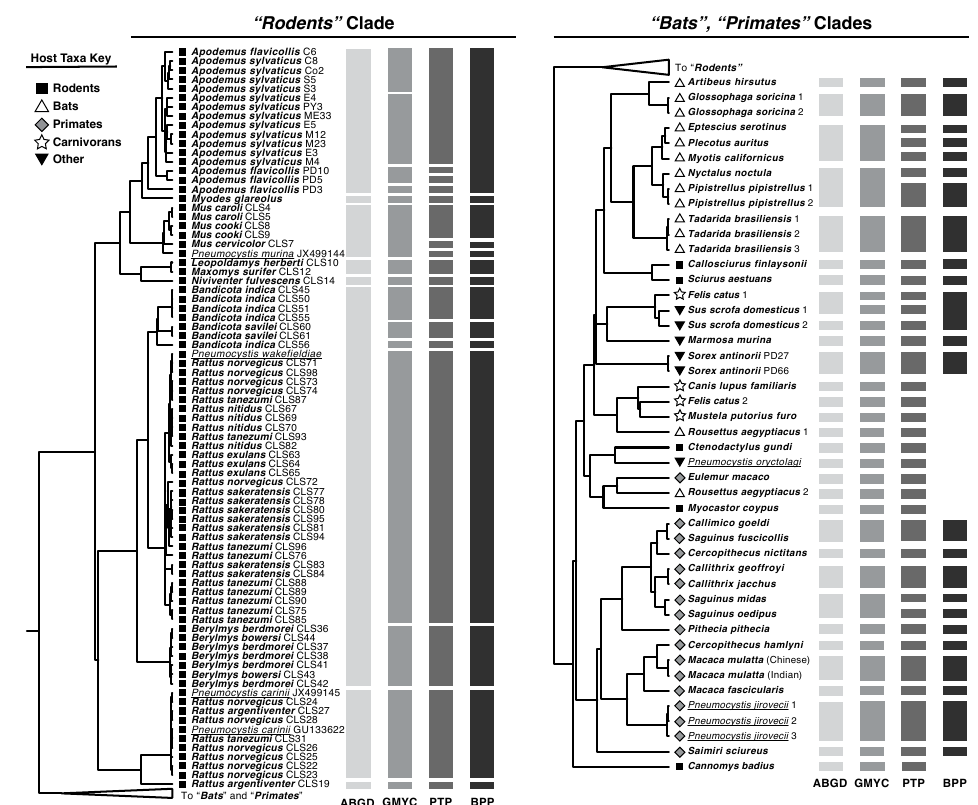
Figure 2. Species delimitation estimates from Pneumocystis in the “ Rodents ” (on left ) and the “ Bats ” and “ Primates ” clades (on right ) generated with four molecular delimitation methods. Node labels refer to the name of the host except where sequences were identified as belonging to a described Pneumocystis species (shown in underlined font). Dark bars represent the boundaries of sequences that were grouped into one species by each